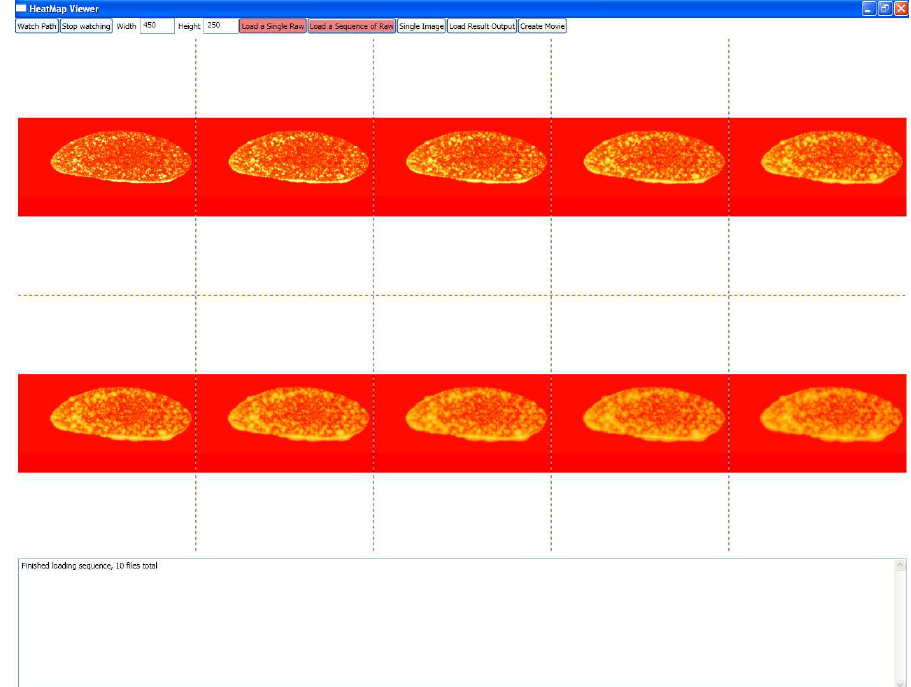
Figure 5: Visualization of Redi outputs as heatmaps. The Red color indicates regions with a lo w concentration of molecules, while yellow and white colors indicate regions occupied by large amounts of molecule